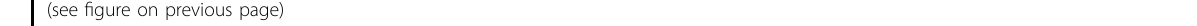
Fig. 6 iIC-stimulated neutrophils produce Fc μ RII-dependent external ROS. A Following incubation with inhibitors, neutrophils were or were not stimulated with 10 μ g/ml iICs for analysis of neutrophil apoptosis after 9 h. B – I Internal and total ROS production was analyzed in neutrophils that had been stimulated with 4 μ g/ml iICs ( B , D-I ) or 25 beads/neutrophil ( C ) as detailed in ‘ Materials and methods ’ . B , C Neutrophils were pre-treated for 10 min with inhibitor or vehicle as indicated prior to performing ROS assays. Internal ( D , F , H ) and total ( E , G , I ) ROS were analyzed with cells that had been pre-incubated for 30 min on ice with blocking antibodies (10.1, AT10, 3G8, ICRF44) or vehicle as indicated prior to stimulation with iICs. D – G Representative examples are shown; H , I Integrated total ROS production. A-C , H, I Each symbol represents the average value obtained in a separate experiment. A , H , I Raw data were analyzed by one-way ANOVA with multiple comparisons post-hoc test; * p < 0.05; ** p < 0.01; *** p < 0.001; n.s. not signi fi